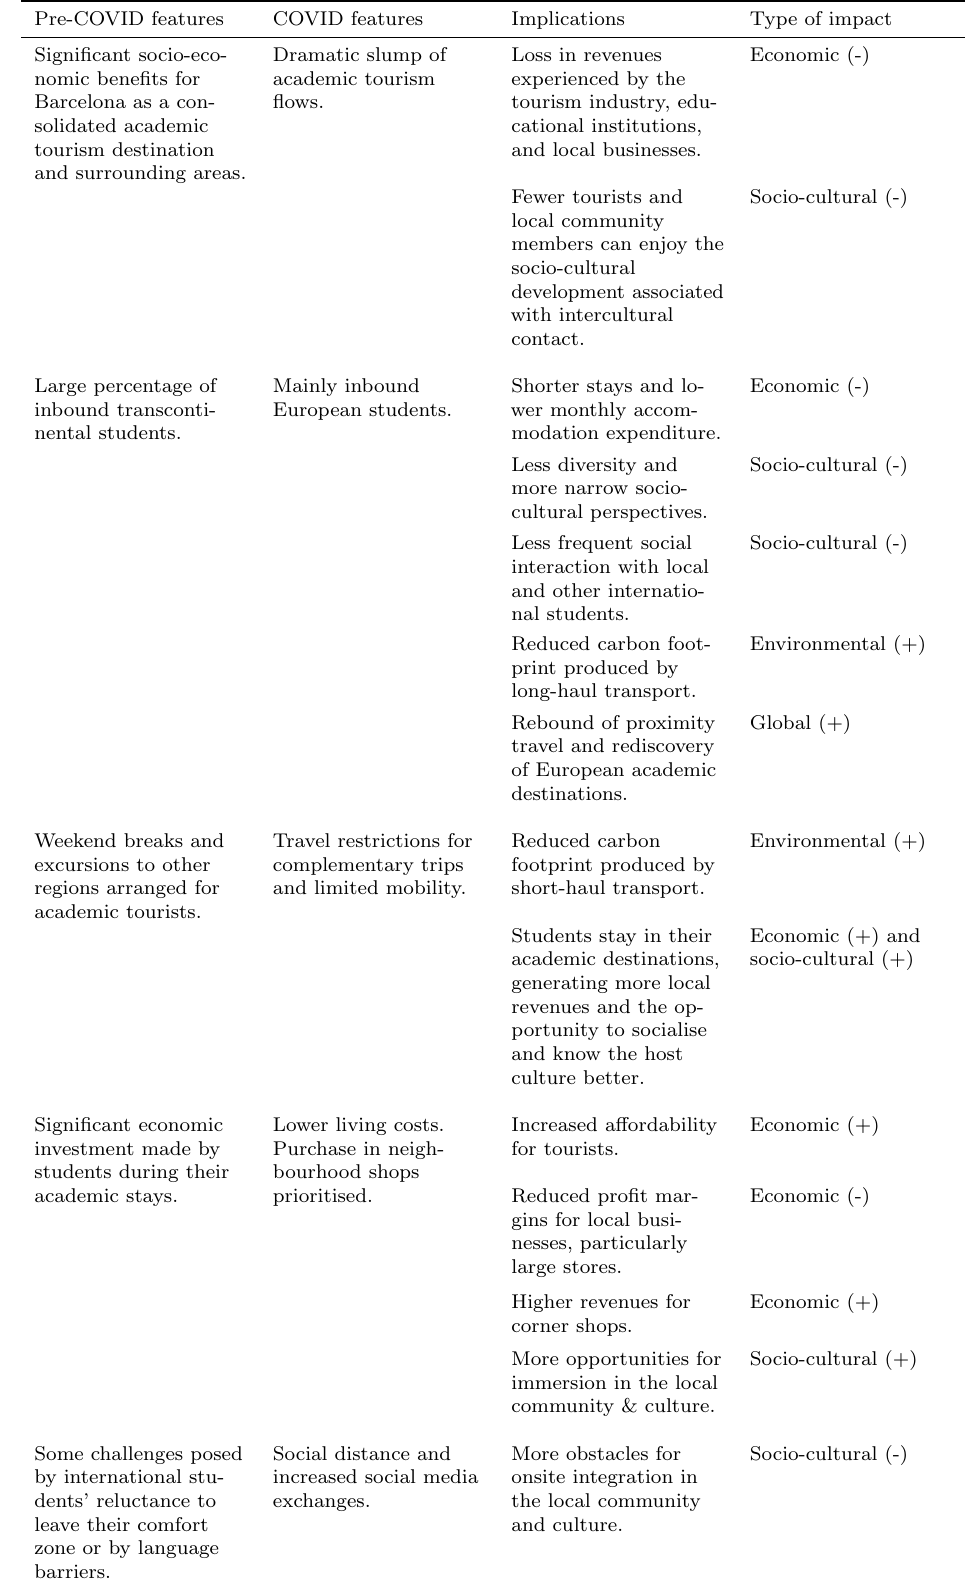
Table 6: Effects of COVID-19 pandemic on academic tourism in